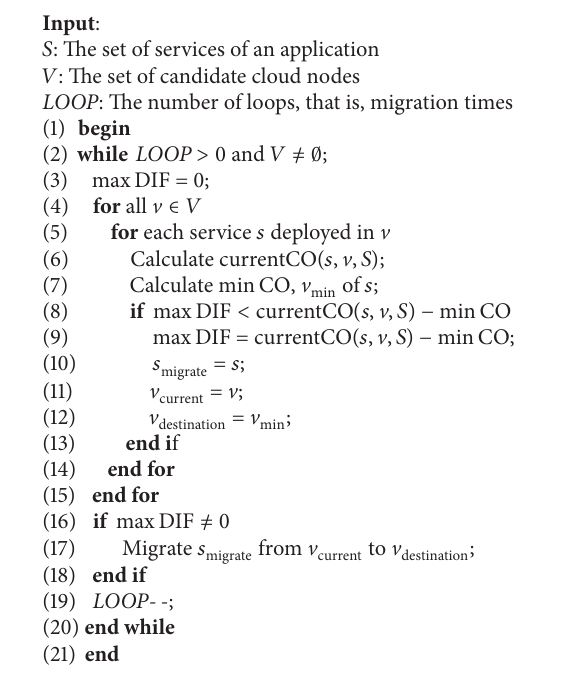
Algorithm 2: Offline